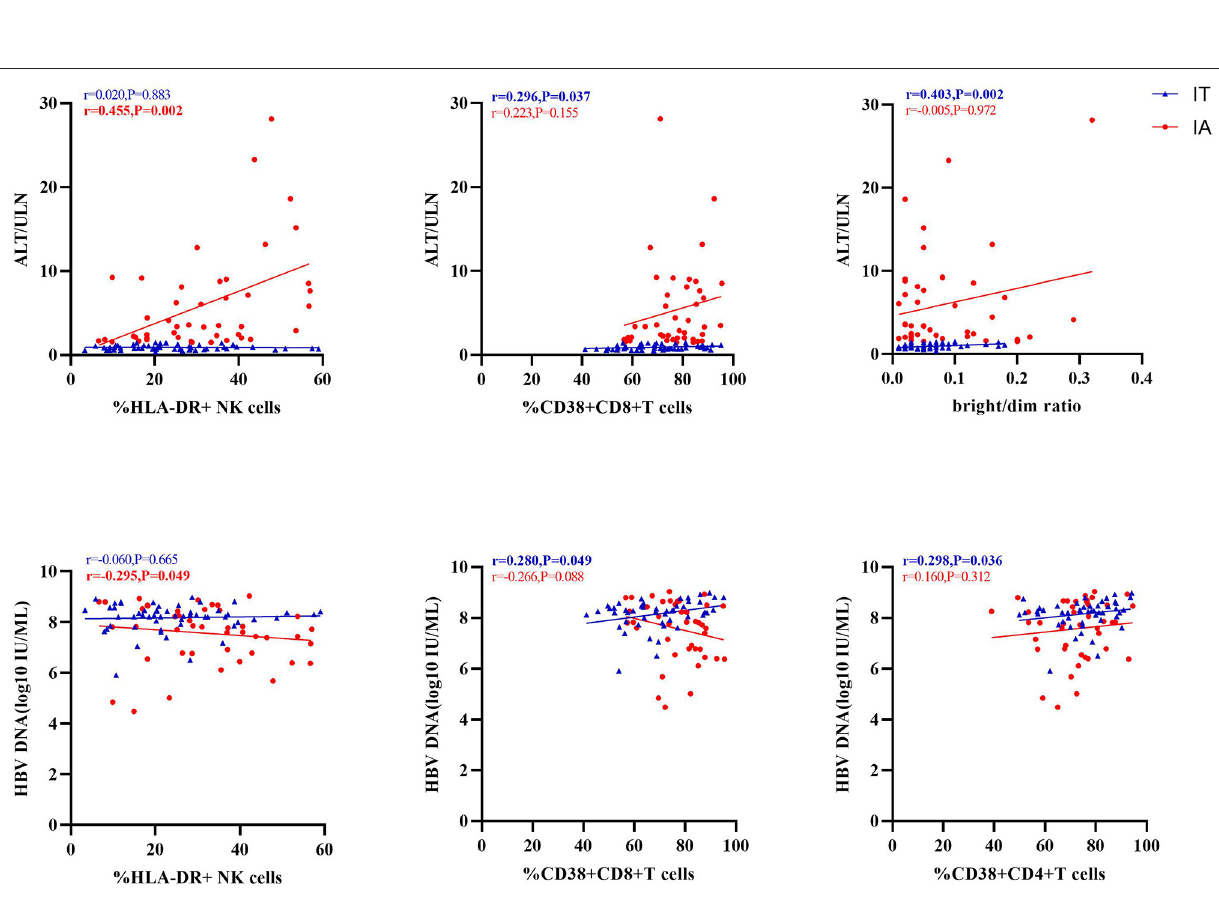
Frontiers in Pediatrics |